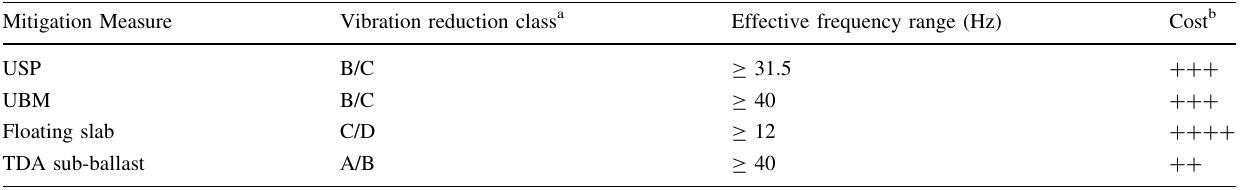
Table 1 Classification of vibration mitigation measures Mitigation